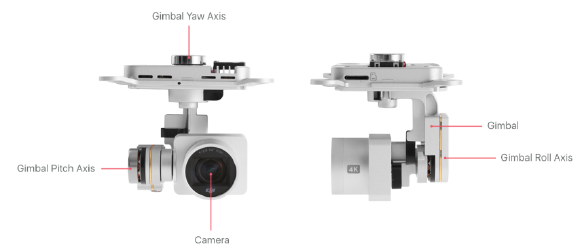
Figure 3. Example of Three Degrees of Freedom (DoF) Gimbal mechanism used on